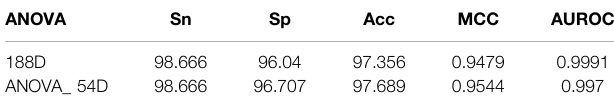
TABLE 2 | ANOVA feature selection methods based on random